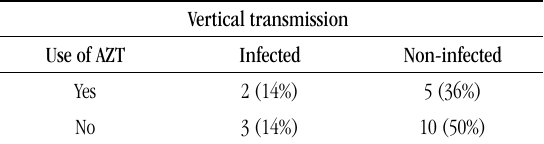
tABLE 3 – Correlation between the use of AZT in pregnant women and vertical transmission Vertical transmission Infected